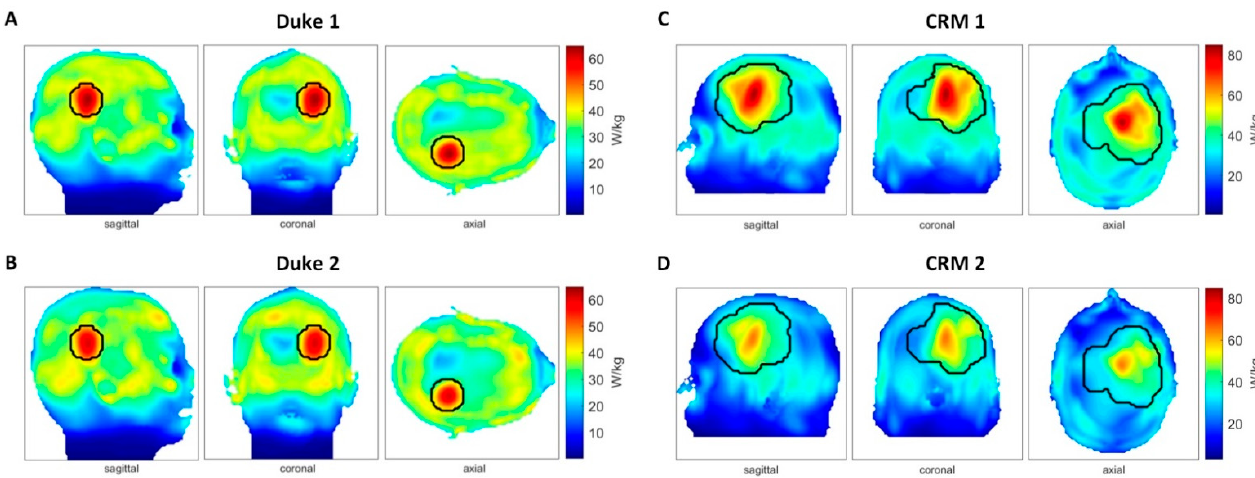
Figure 8. Impact of head displacement on RF heating obtained from electromagnetic field (EMF) simulations using human head models without (center position) and with movements (5 mm off-center position). ( A ) SAR 10g (specific absorption rate) maps (maximum intensity projection: MIP) obtained for the Duke model placed in the center of the RF applicator (Duke 1). The phase and amplitude setting of the RF heating was optimized for this position. ( B ) SAR 10g maps (MIP) derived from the Duke model being shifted 5 mm upwards (Duke 2). Phase and amplitude settings were identical with the used settings when the head model was placed in the center position. Several hotspots were generated in healthy tissue. ( C ) SAR 10g maps (MIP) obtained for the clinically relevant head model placed in the center of the RF applicator (clinically relevant model (CRM) 1). The phase and amplitude setting of the RF heating was optimized for this position. ( D ) SAR 10g maps (MIP) derived from the clinically relevant head model using an off-center (5 mm shift upwards) positioning (CRM 2) in conjunction with the same phase and amplitude settings used for ( C